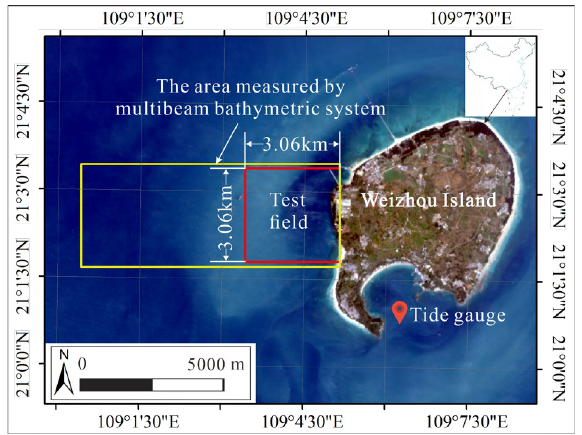
Figure 2. Test field.